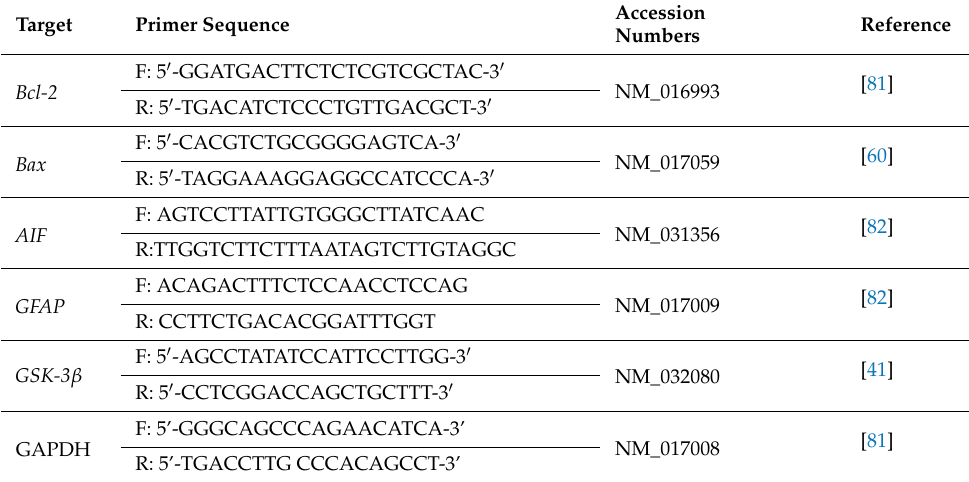
Table 5. Primer sequences for Real-Time RT-PCR